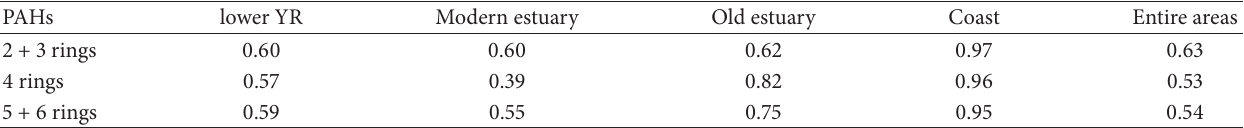
Table 1: Linear correlations ( 𝑅 ) of TOC against PAH concentration (ng g − 1 dws) along the transect of lower Yellow River (YR), river mouth, and adjacent